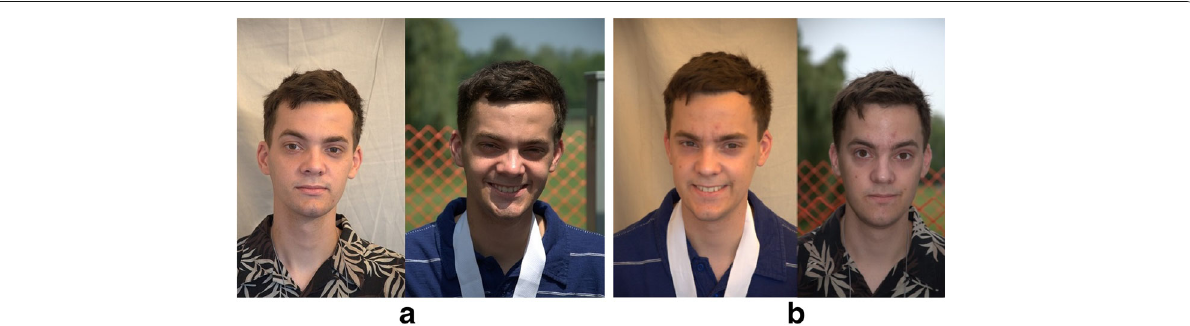
Fig. 3 Example frontal faces. Images in a are of the first twin under different illumination and expression while images in b are of the second twin under different illumination and expression